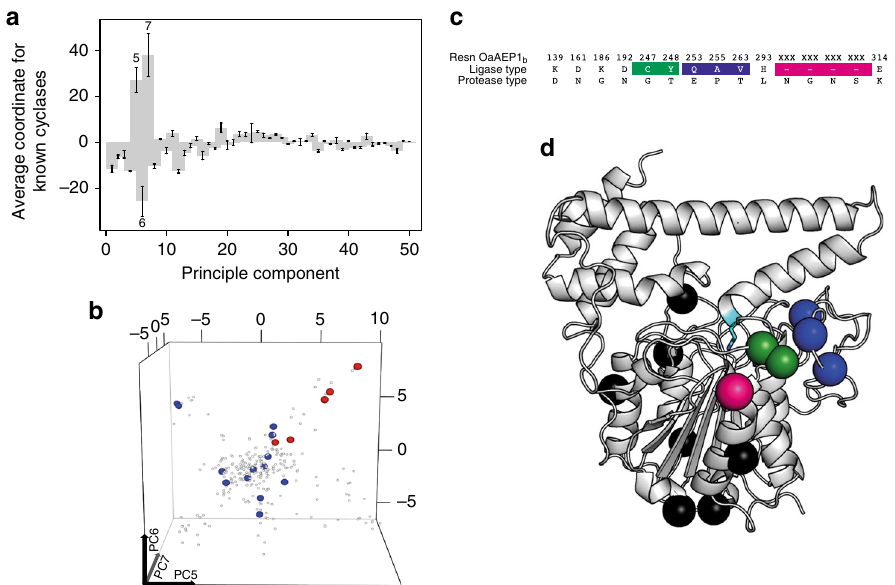
Fig. 5 Plant AEP protein sequence space modeling. a Average protein sequence space coordinates of the six known ligases (Supplementary Data 1, Supplementary Table 2). b Plant AEP protein sequence space pro fi les after principle component analysis. Each point indicates a sequence, with its coordinates in the space determined by its residue properties. Axes are principle components 5, 6 and 7, which showed signi fi cant separation of known ligases (red) and proteases (blue) (Supplementary Table 2). c The 16 ligase predictive residues and positions on OaAEP1 b . Color shading used is the same as in Fig. 2a. d Structure of the zymogen OaAEP1 (PDB accession 5HOI) with positions of ligase-preferred residues displayed. Residues shown in green include those closest to the substrate pocket, which includes the Gatekeeper residue Cys247 and the adjacent Tyr248. Those in blue are situated within the plant AEP-speci fi c poly-proline loop, while the magenta colored sphere represents the position of the 4-amino acid deletion in the MLA. The seven spheres in black represent the residues most distal from the catalytic active